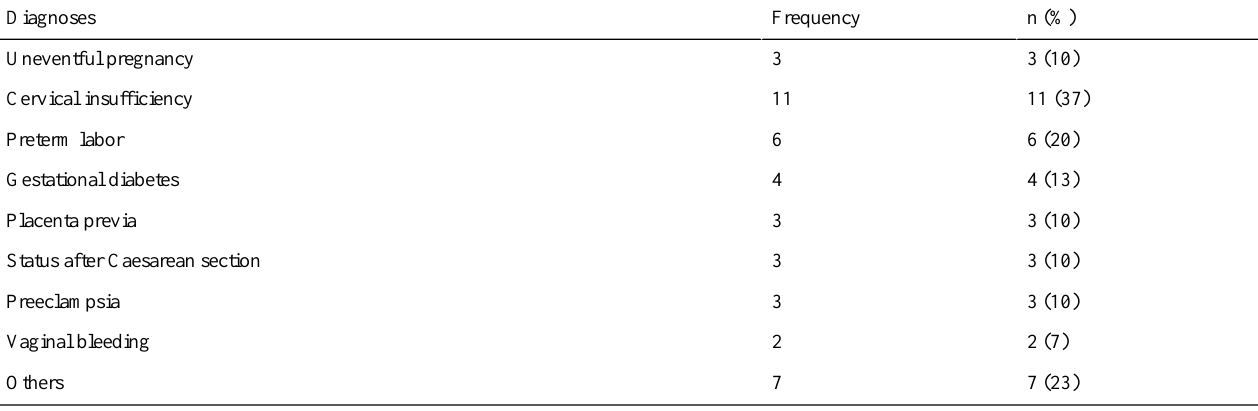
Table 2. Diagnoses (N=30; multiple answers